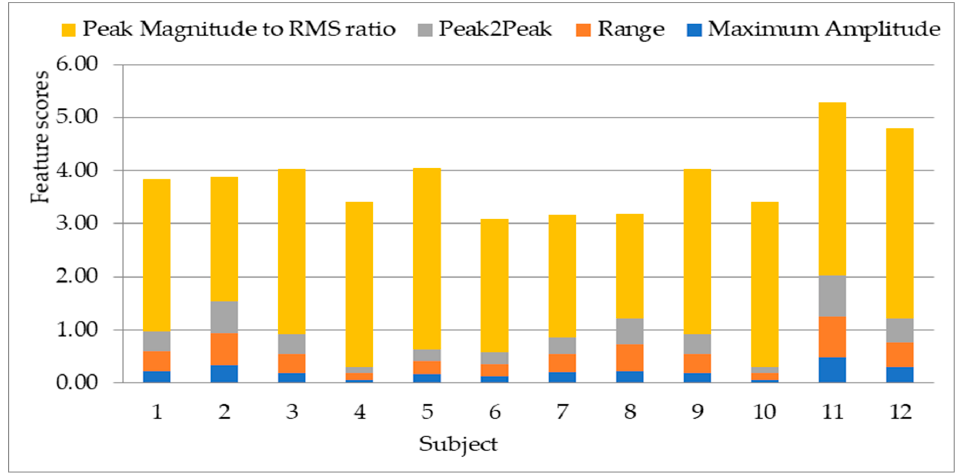
Figure 10. Variation of maximum amplitude, range, peak2peak and peak magnitude to root mean square (RMS) ratio on twelve subjects.